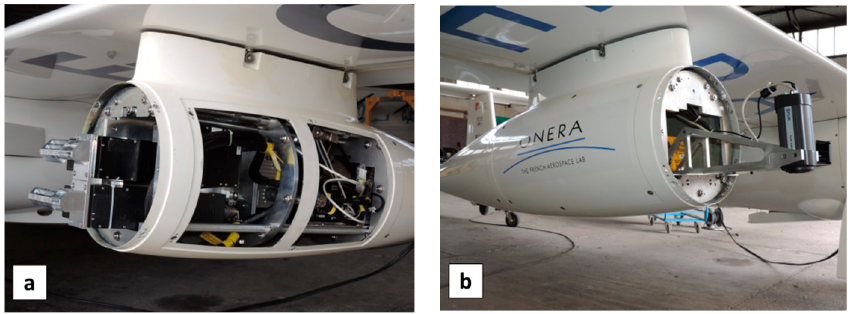
Figure 1. ( a ) VNIR1600 and SWIR320m ‐ e HySpex hyperspectral cameras on ‐ board left pod of motor ‐ glider STEMME; ( b ) IR microbolometer camera (FLIR A325) onboard right pod.